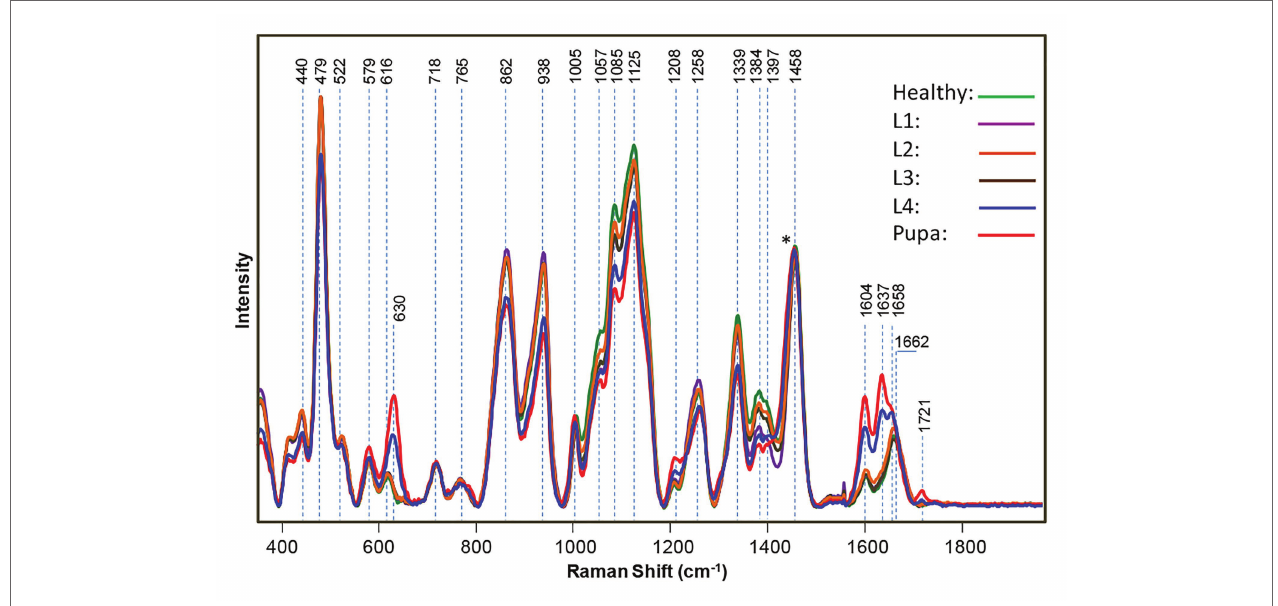
FIGURE 7 | Raman spectra of healthy, uninfested cowpea seeds and seeds infested by bruchids at larval and pupal stages, normalized to the 1,458 cm −1 peak [indicated by an asterisk ( * )]. Reproduced with permission from Sanchez et al.